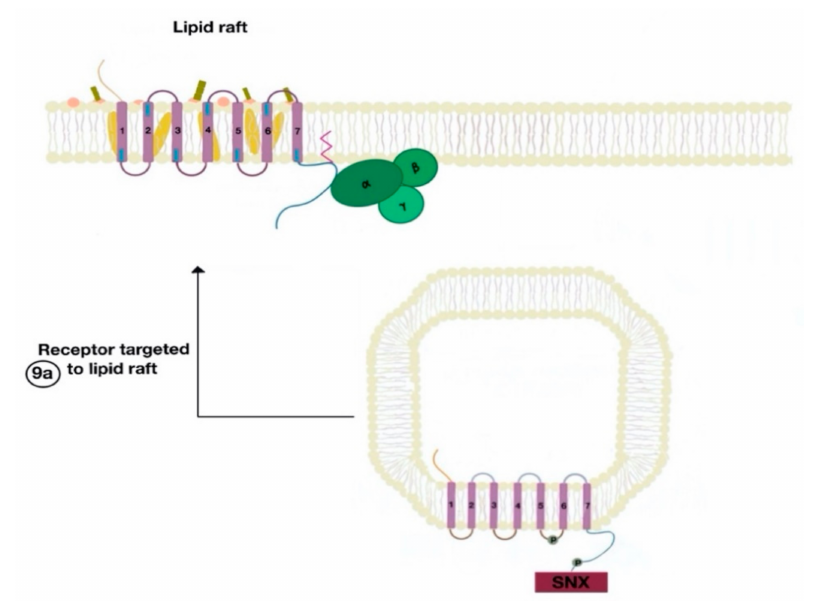
Figure 9. The resensitized GPCR (dopamine receptor) is targeted to the lipid raft microdomain by SNX (9a) and is ready to bind to a new agonist (9a).